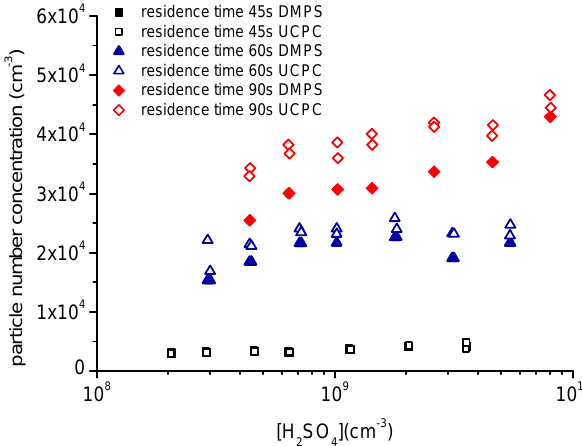
Figure 3. The observed particle number concentrations at different residence times at T = 293K and with an RH of ∼ 30%. The solid symbols present the number concentrations determined by a DMPS and the open symbols are number concentrations determined by a